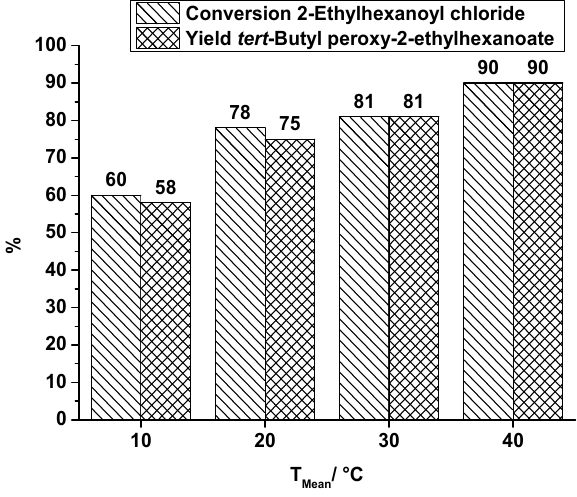
Figure 8. Capillary tube reactor with ultrasonication, conversion and yield of TBPEH synthesis, 2nd reaction step at a total flow rate of 0.3 mL · min − 1 depending on the reaction temperature.